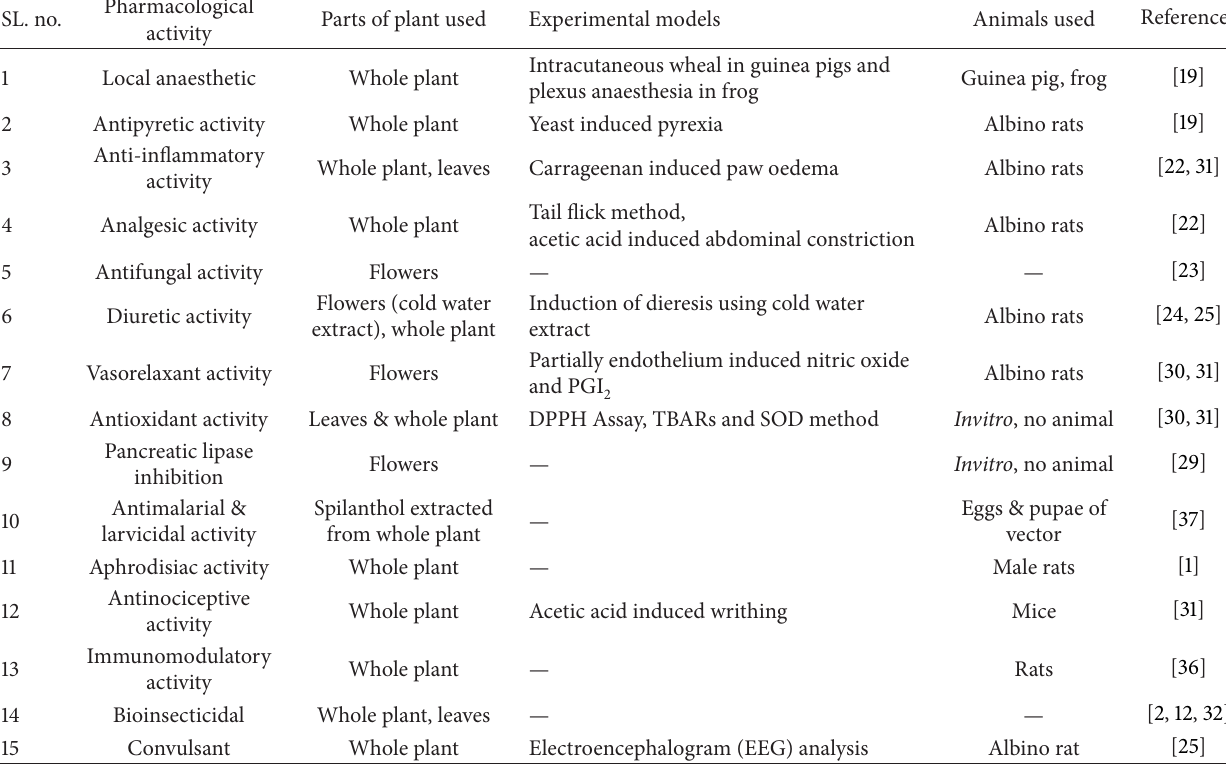
Table 2: Summary of pharmacological actions of Spilanthes